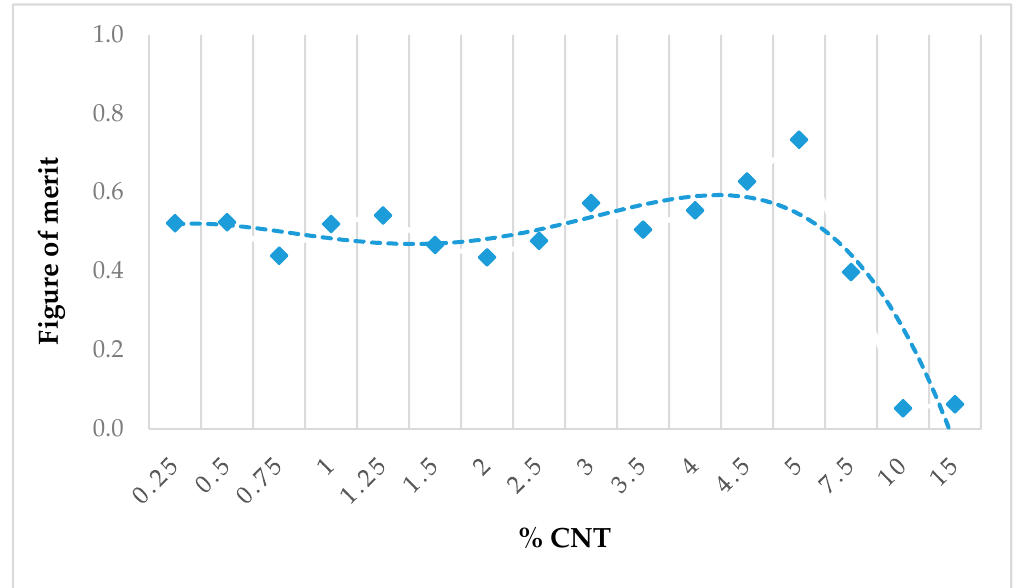
Figure 6. FOM (figure of merit) versus wt.% CNT. Symbols: measurement, dashed line: polynomial fit.